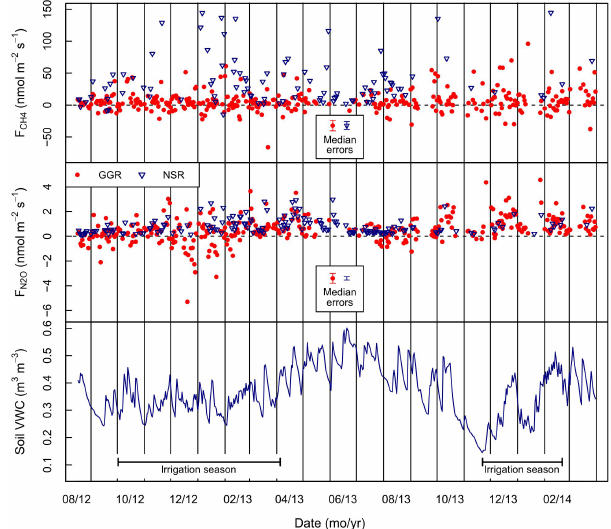
Figure 5. Half-hourly fluxes of CH 4 (top) and N 2 O (middle) at the two sites, obtained with the GGR method, as well as wind speed (bottom), for an example period.